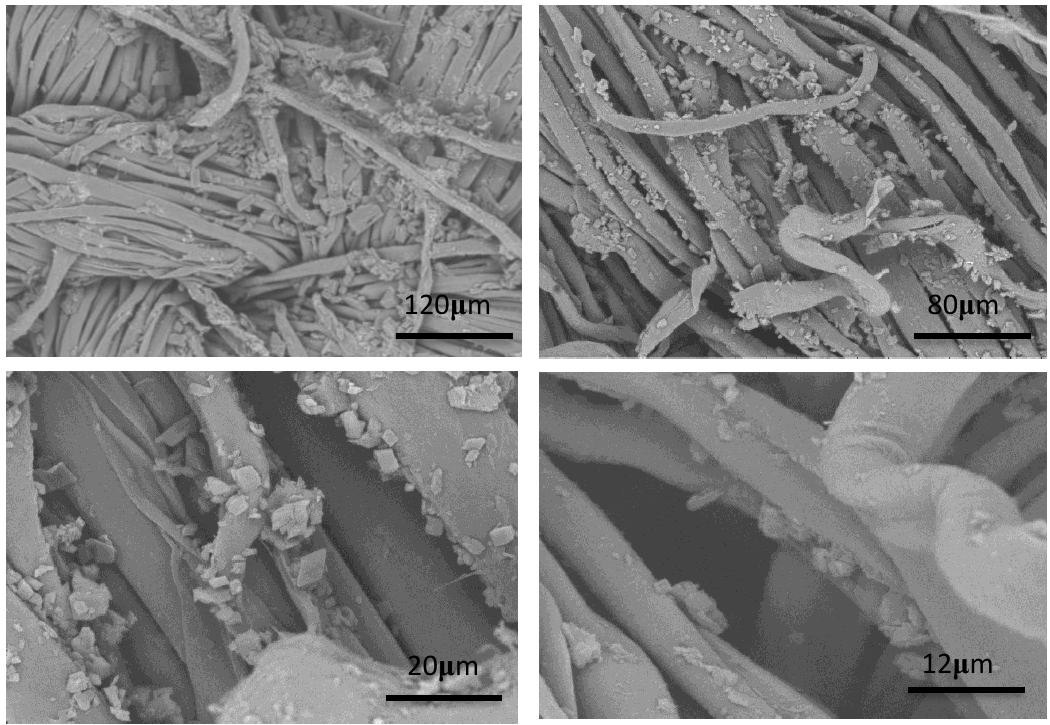
Figure 8. SEM photographs of fabrics finished with double-layered microcapsules.